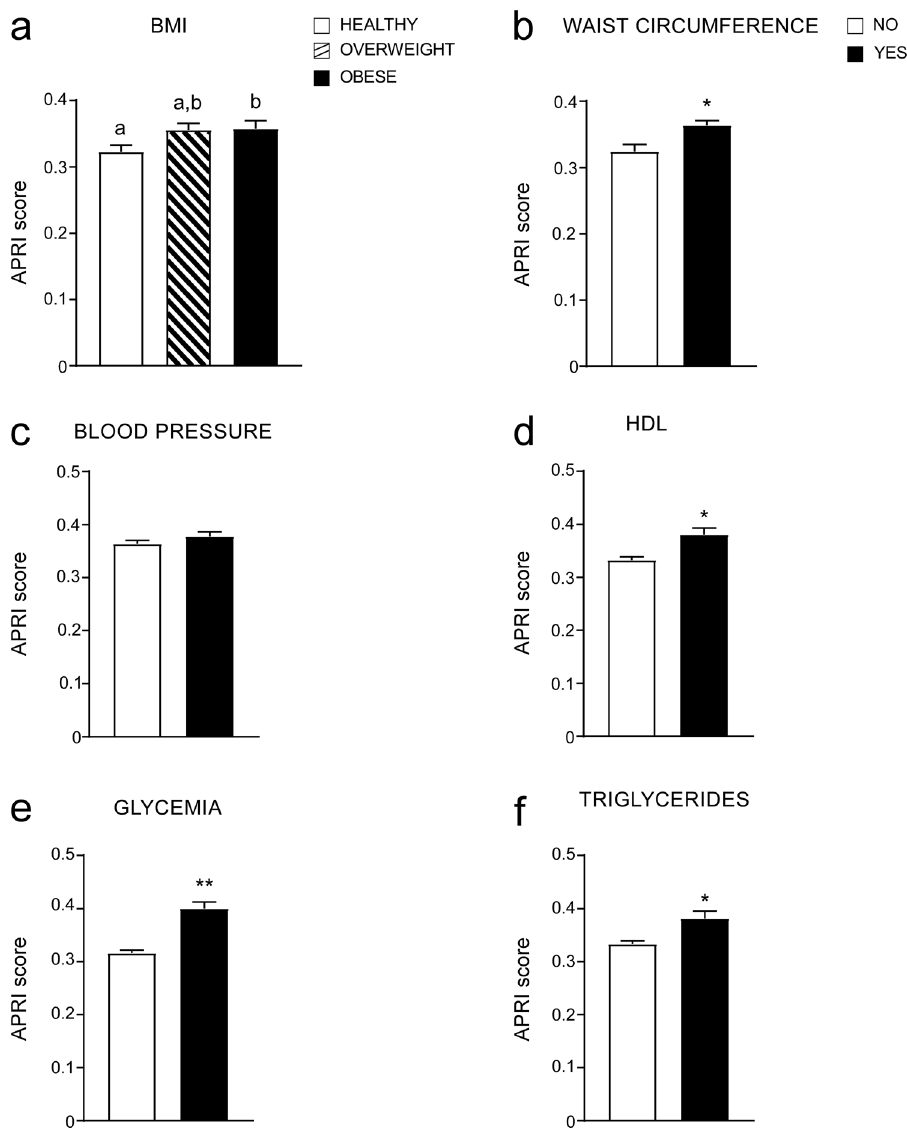
Figure 2. APRI score levels analyzed by single MetS criterion and BMI cut-offs. ( a ) Comparison of APRI values according to BMI definition. Subjects were divided in three different categories. Healthy = n. 412, Overweight = n. 421, Obese = n.305. Data is presented as mean ± SEM. Comparison of groups was performed using one-way ANOVA test followed by Bonferroni’s post-hoc test. Data from groups sharing the same lowercase letters were not significantly different, whereas data from groups with different case letters were significantly different (p < 0.05). ( b – f ) T-Test comparison of APRI values in subjects divided by positivity for each MetS criterion according to IDF definition. Data is presented as mean ± SEM. *p < 0.05, **p <